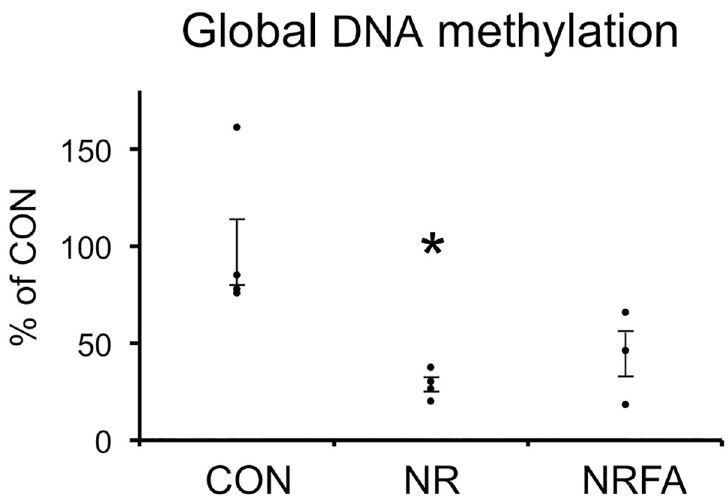
Fig 3. Effect of maternal nutrient restriction with or without folic acid supplementation on global DNA methylation of rat E18 embryonic kidney. CON, controls (n = 4 litters); NR, offspring of nutrient-restricted mothers (n = 4 litters); NRFA, offspring of nutrient-restricted mothers. supplemented with folic acid (n = 3 litters). n = 9–15 animals per litter. The mean value of each litter was used for statistical analysis (ANOVA followed by Tukey’s test). Dots indicate the mean value of each litter. Bars represent ± SE. � , P < 0.05 vs CON.